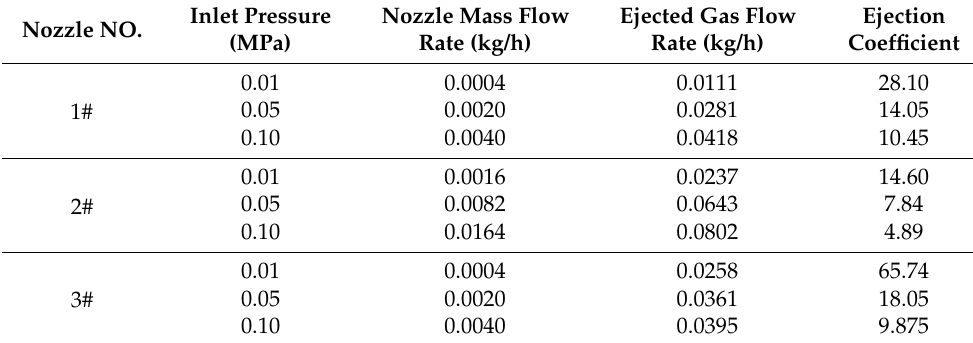
Table 3. Ejection characteristics of the three ejector nozzles.